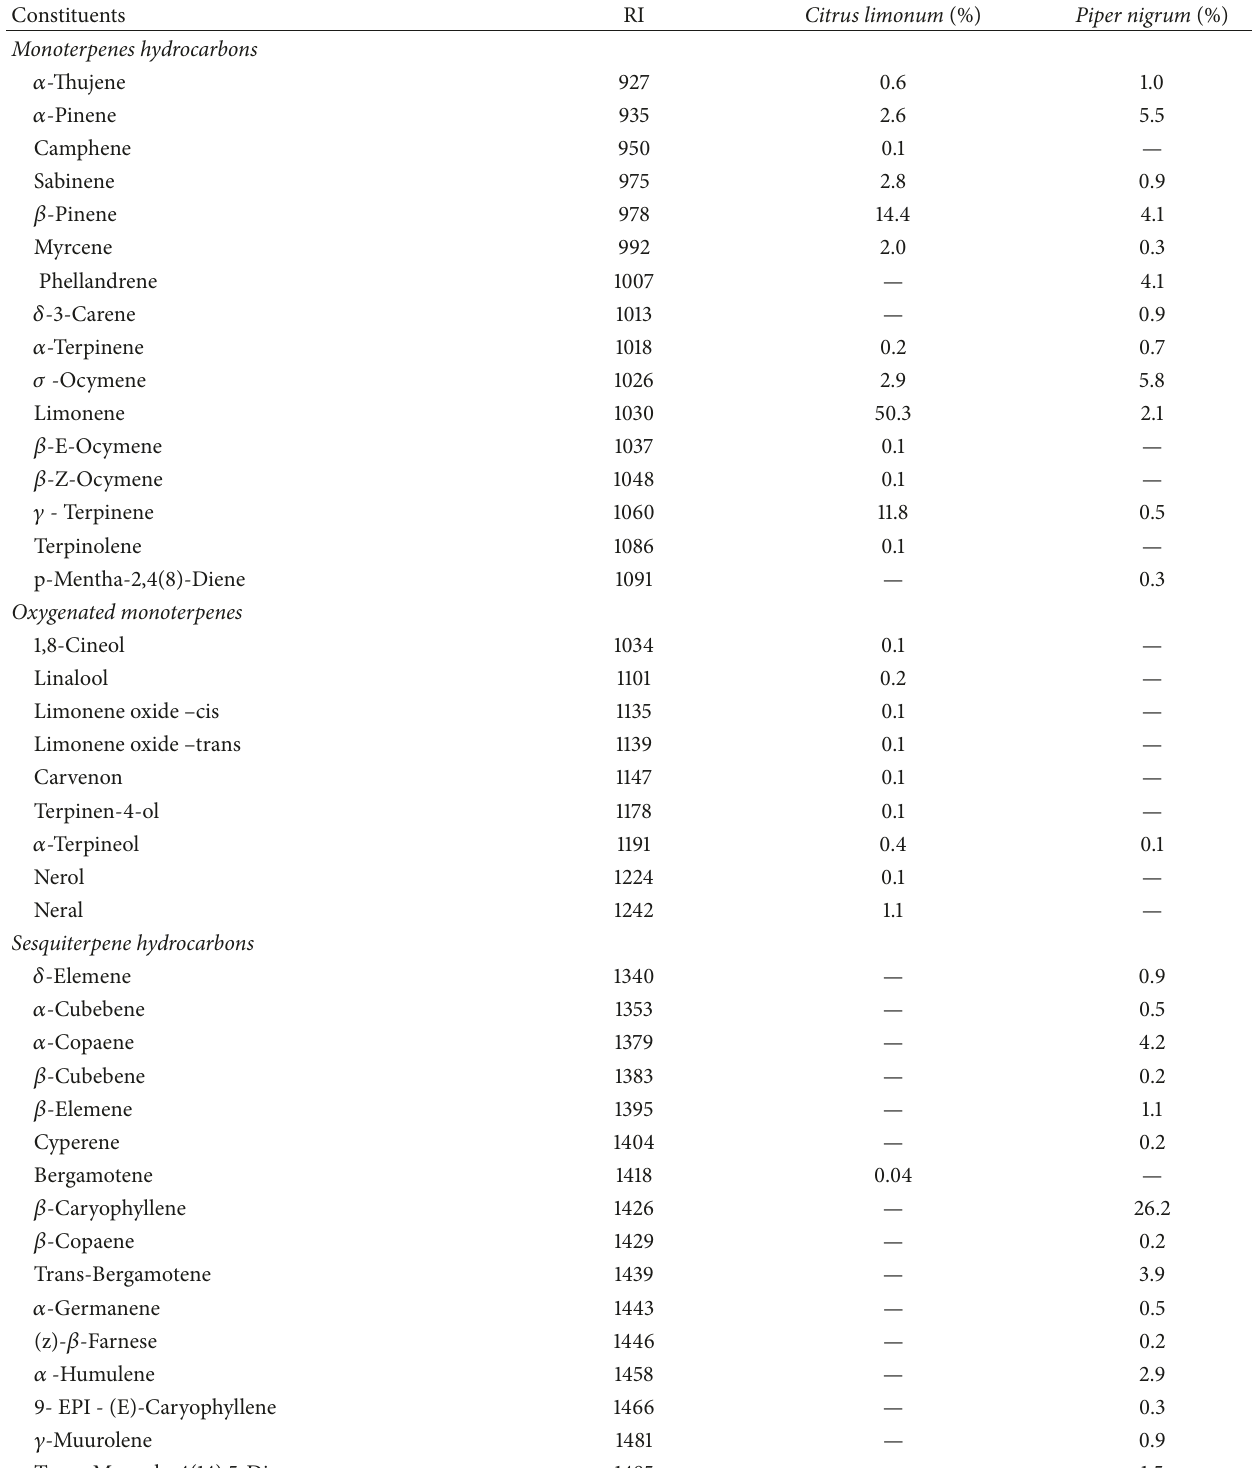
Table 1: Percentage composition of Citrus limonum and Piper nigrum